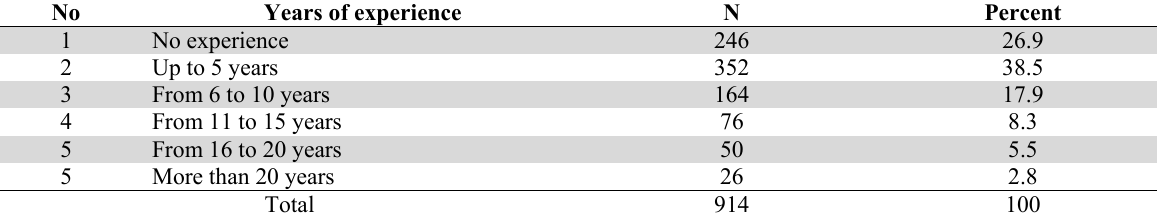
Breakup of the sample based on